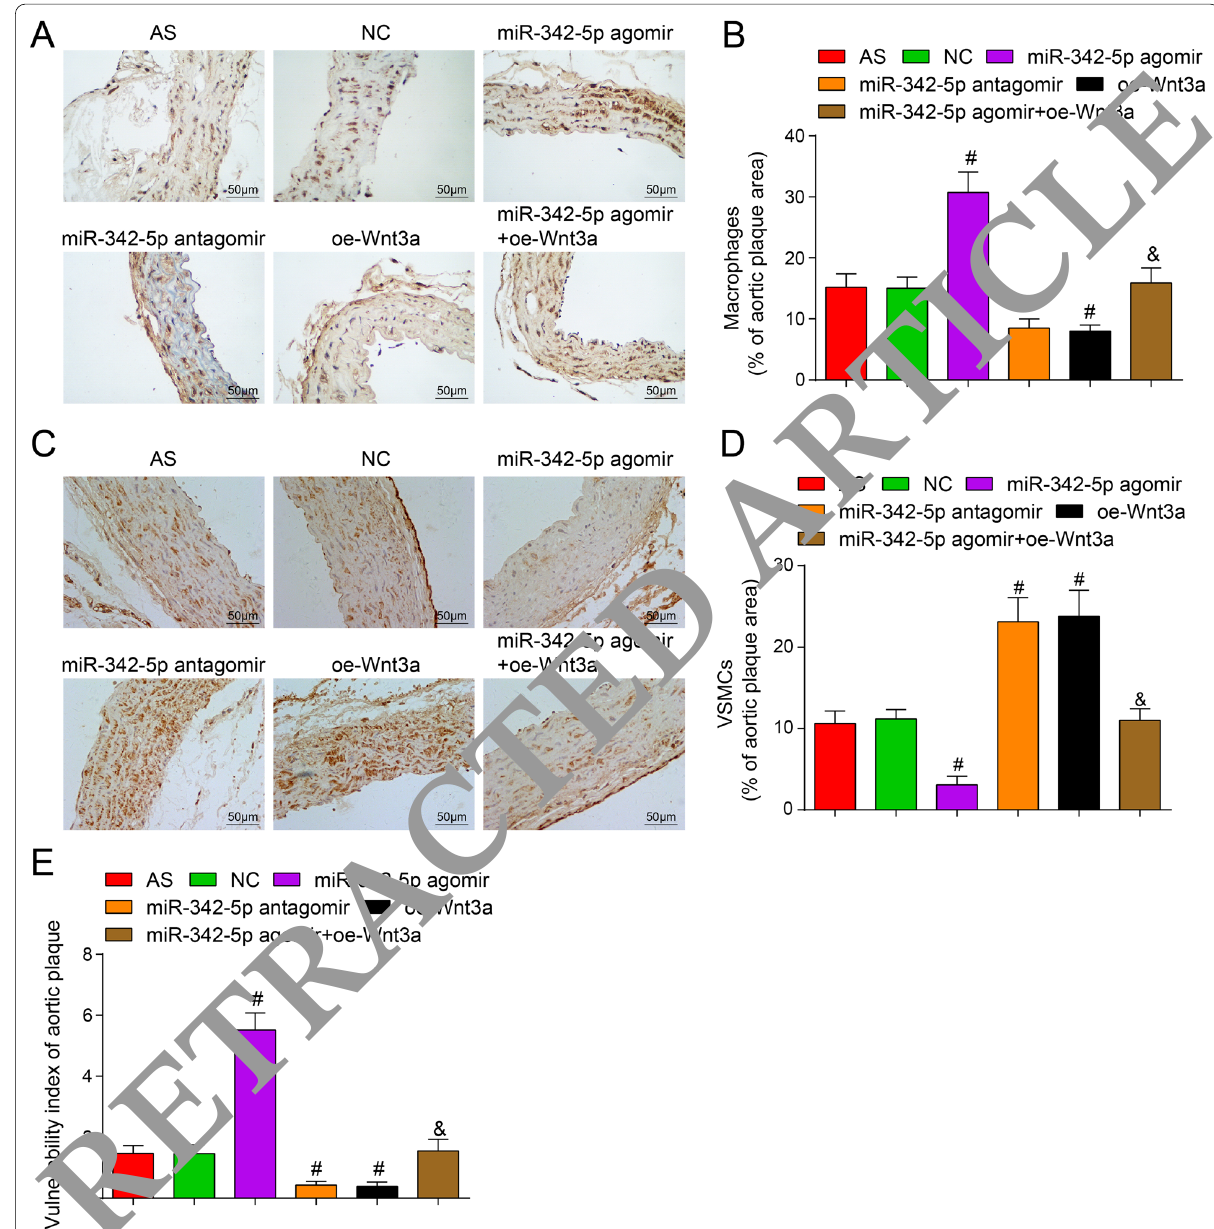
Fig. 5 Effects of high expression of Wnt3a or poor expression of miR-342-5p on aortic plaque vulnerability of ApoE − / − mice. A Immunohistochemical staining of MOMA-2 in each group of mice (scale bar: 50 μm). B Quantitative analysis of figure A. C Immunohistochemical staining of α-SMA in each group of mice (scale bar: 50 μm). D Quantitative analysis of figure C . E Comparison of plaque vulnerability index in aortic tissues of AS mice. n 12. # P < 0.05 vs. the NC group. & P < 0.05 vs. the miR-342-5p agomir group. Measurement data were indicated as = mean standard deviation. Comparisons among multiple groups were assessed by one-way ANOVA followed by Tukey’s multiple comparisons test. ± AS, atherosclerosis; NC, negative